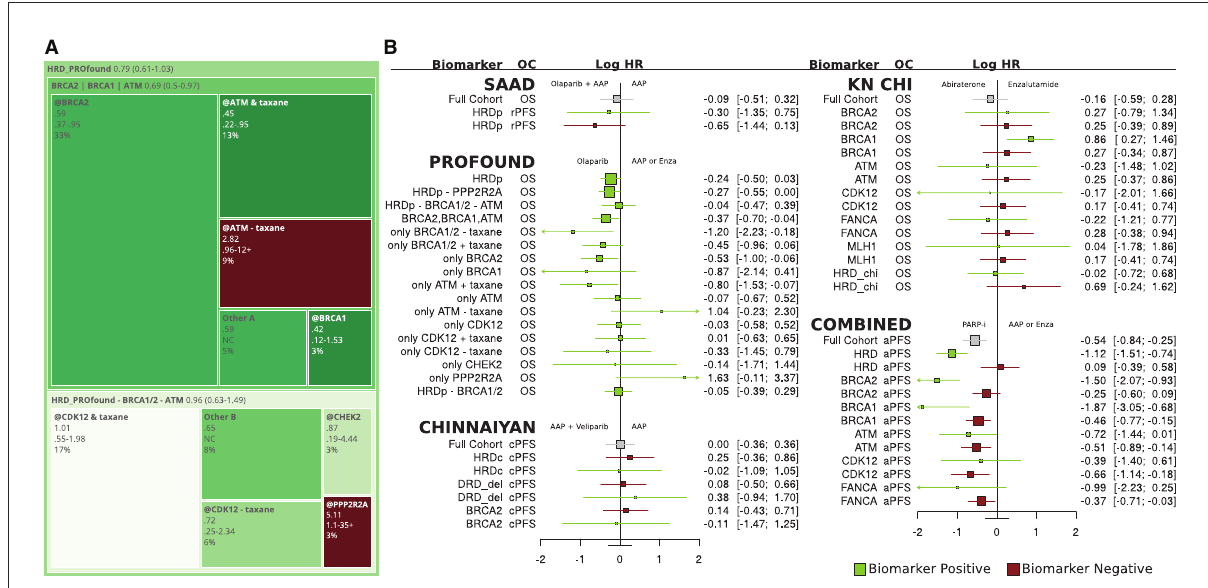
FIGURE4 (A) Treemap for PROfound overall survival hazard ratios for olaparib relative to physicians’ choice of AAP or Enz. (B) Forest plot of overall survival and progression-free survival hazard ratios for olaparib relative to AAP or physicians’ choice of AAP or Enz for Saad, PROfound, Chinnaiyan, CHI, and combined